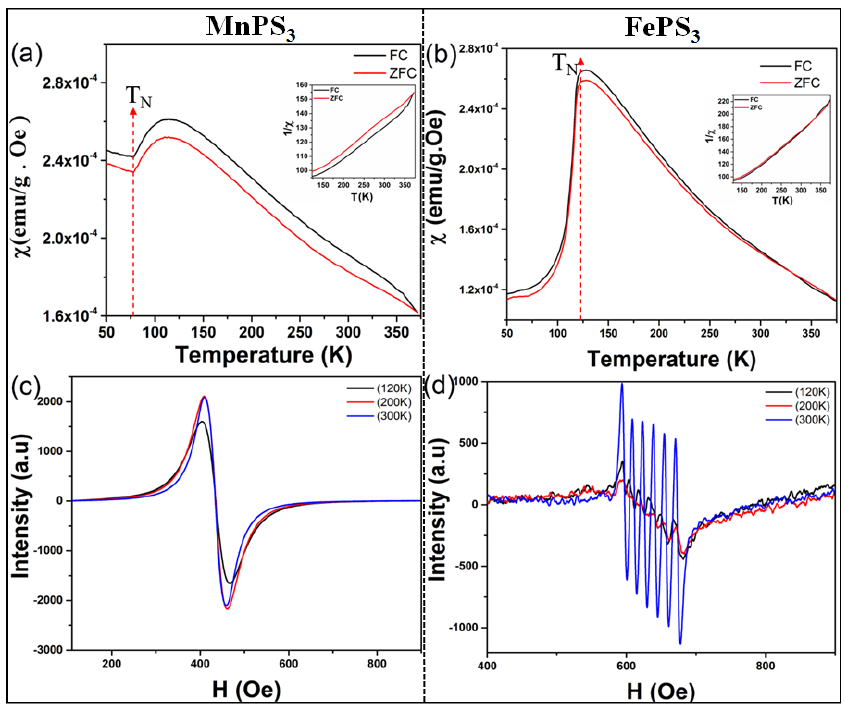
Figure 4. Magnetic susceptibility of ( a ) MnPS 3 and ( b ) FePS 3 single crystals with millimeter size. Electron paramagnetic resonance spectra of ( c ) bulk MnPS 3 and ( d ) FePS 3 single crystals.